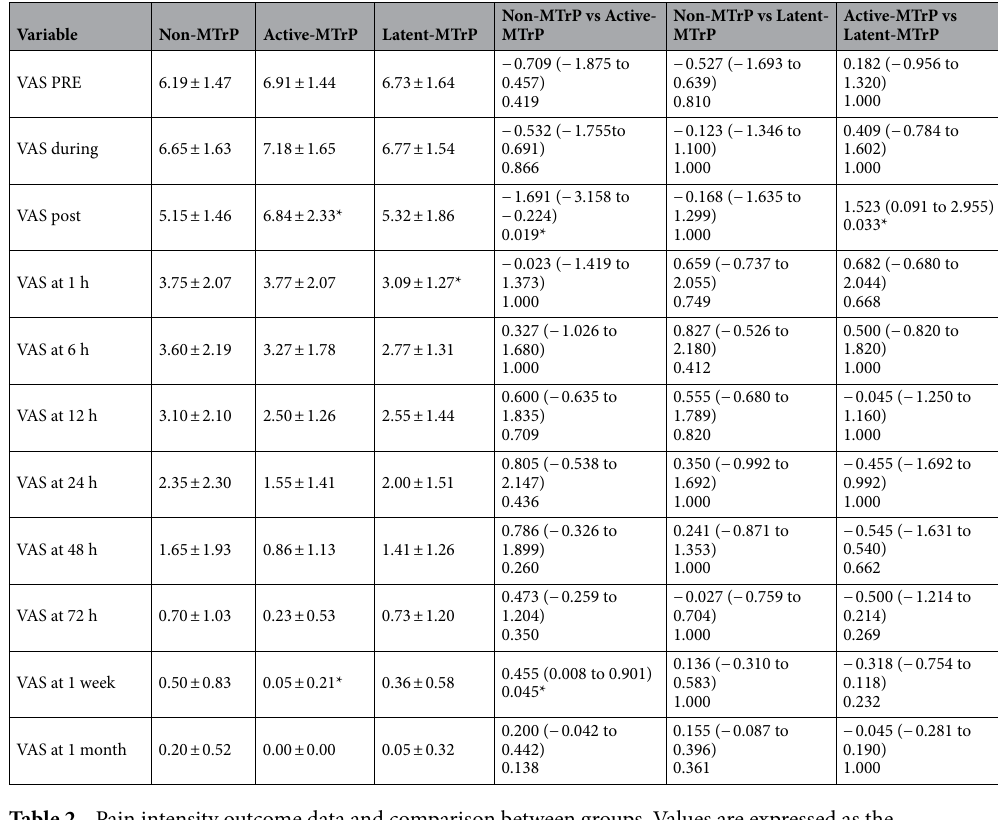
Table 2. Pain intensity outcome data and comparison between groups. Values are expressed as the mean ± standard deviation. In comparison between groups: Difference of means, Confidence interval and P value according to Bonferroni’s correction. *Indicates statistical significance P < 0.05.